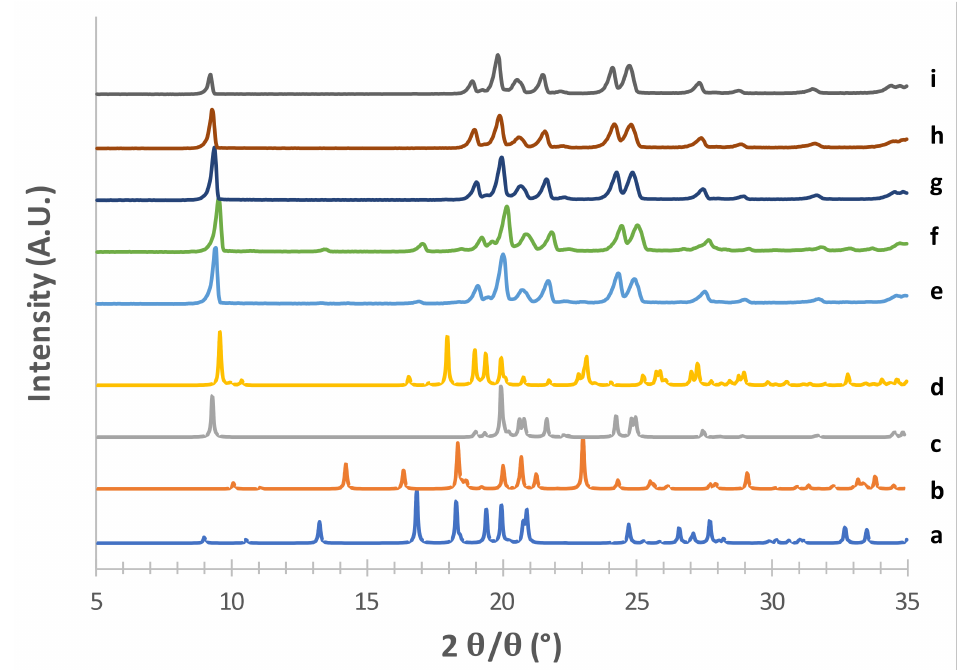
Figure 3. PXRD patterns of mannitol δ form (i) obtained using acetone as an antisolvent with 3% PVP (h), 2% PVP (g), 1% PVP (f), 0.5% PVP (e) without PVP. Patterns of all polymorphs are added as references (a) α form CCDC 224658; (b) β form CCDC 224659; (c) δ form CCDC 224660; (d) hemihydrate form CCDC